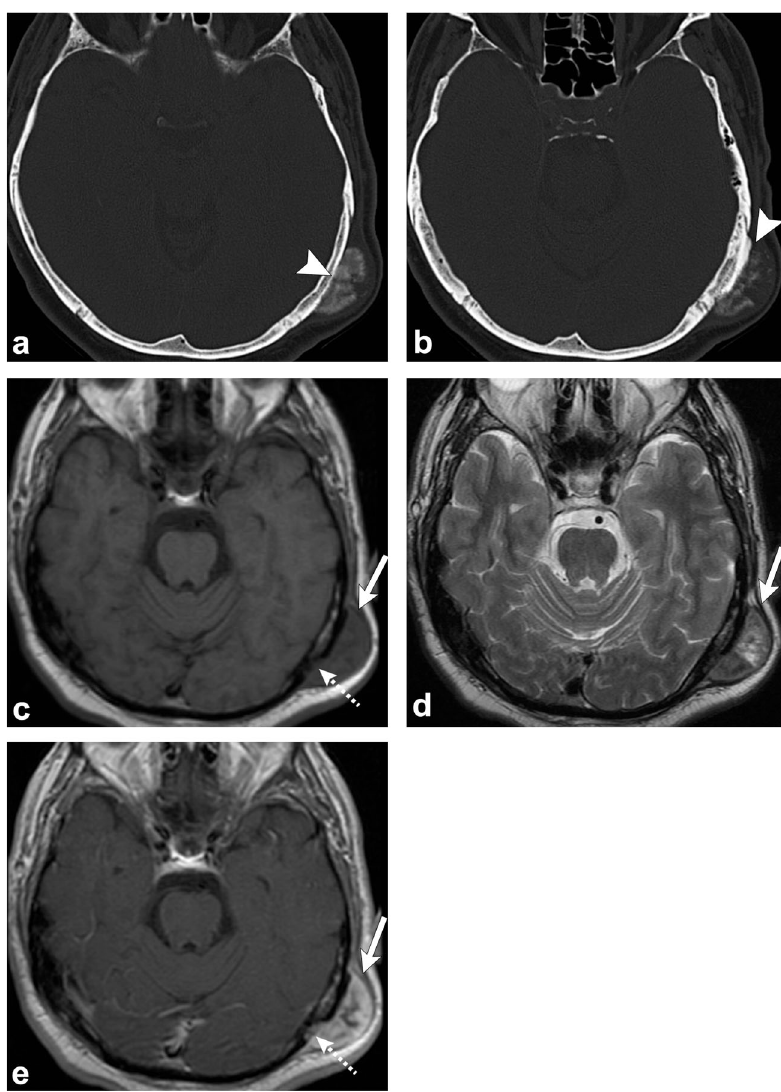
Fig. 17 Parosteal osteosarcoma. Axial CT ( a , b ) images show a lobulated exophytic mass ( arrowheads ) with central dense ossification in the left temporo- occipital region. Axial T1- weighted ( c ), axial T2-weighted ( d ) and axial post-contrast T1- weighted ( e ) images re- demonstrate a juxta-cortical enhancing lesion abutting the outer table of the left temporo- occipital bones ( arrows ) with a small component extending into the medullary cavity with associated cortical disruption ( dashed arrows